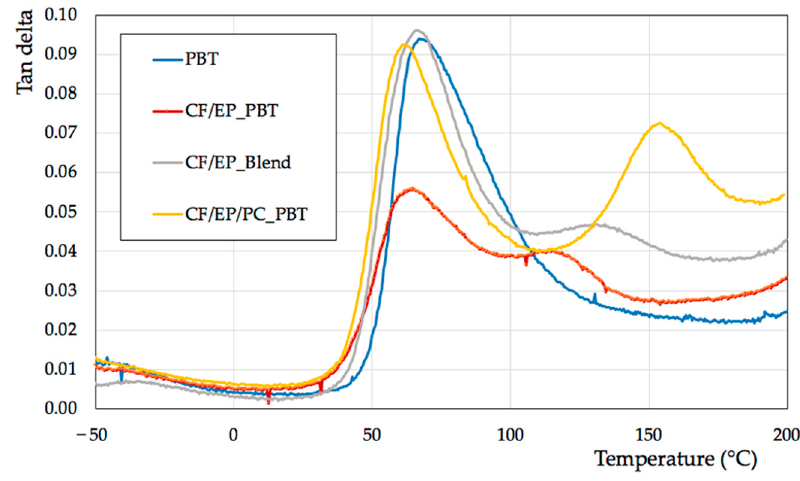
Figure 4. Loss factor (tan δ ) of the investigated materials.